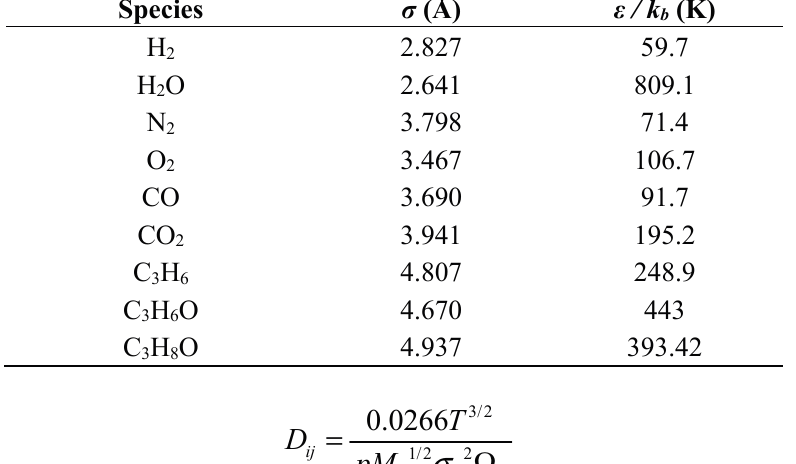
Table 4. Hard-sphere collision diameter and Lennard–Jones energy parameter for various